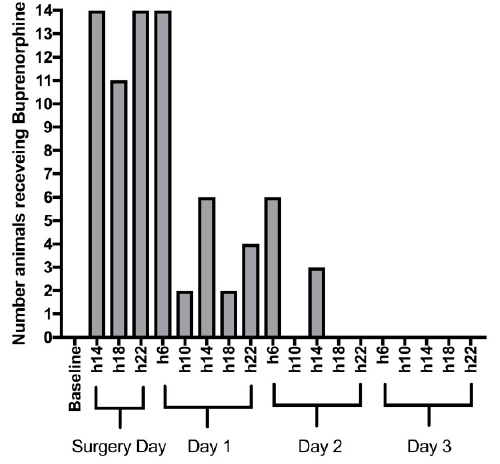
Figure 2. Number of rabbits (out of 14) administered buprenorphine after each assessment (06:00 am, 10:00 am, 14:00, 18:00 and 22:00), after surgical creation of critical-sized defects in the calvarial